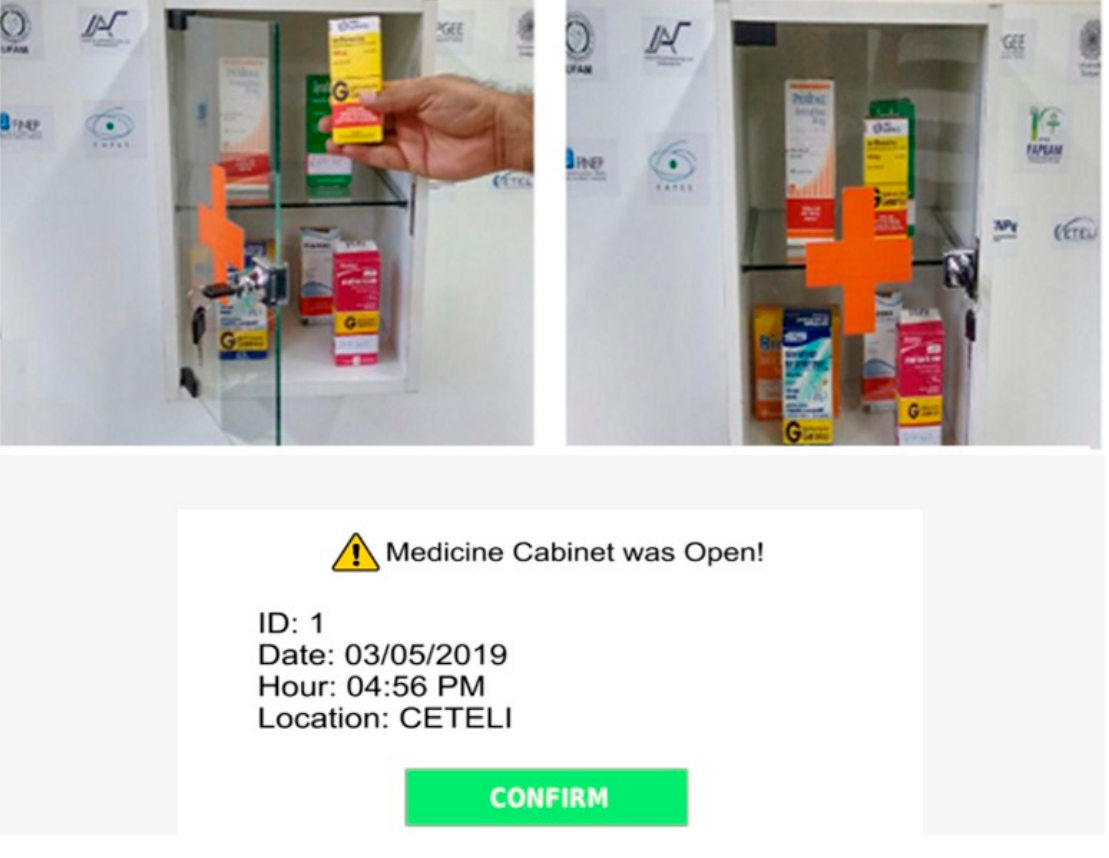
Figure 4. Medicine cabinet system and system log.